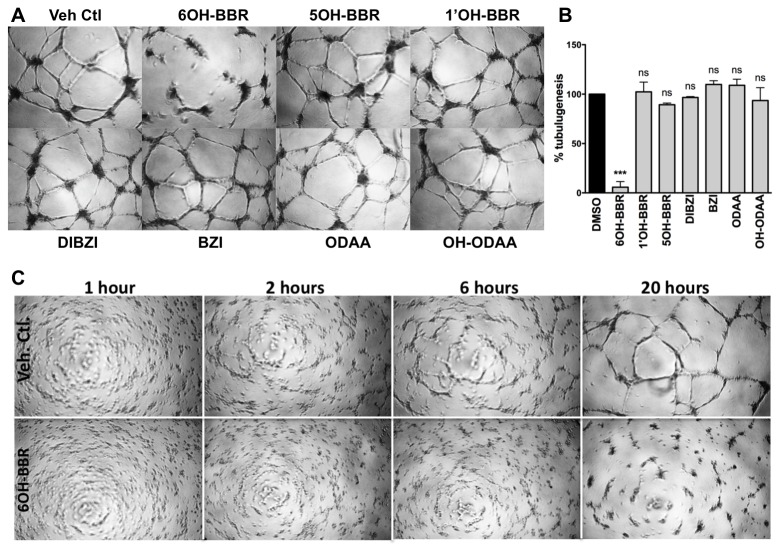
Effect of BBR derivatives on tubulogenesis of HUVECs.(A) Representative phase-contrast images of HUVECs plated on growth-factor reduced Matrigel in the presence of the indicated doses of test compounds, photographed 16 hours after plating. (B) Quantitation of the number of tube-like structures formed by HUVECs in the presence of test compounds. The number of tubes was measured using NeuronJ. Data are mean and standard error of two independent experiments. p-values from a one-way ANOVA are shown; ns is not significant, * P<0.05, ** P<0.01, *** P<0.001. (C) Time course of HUVEC tubulogenesis in the presence of either vehicle control (DMSO) or 6OH-BBR, photographed at 1 hour, 2 hours, 6 hours and 20 hours post-seeding.